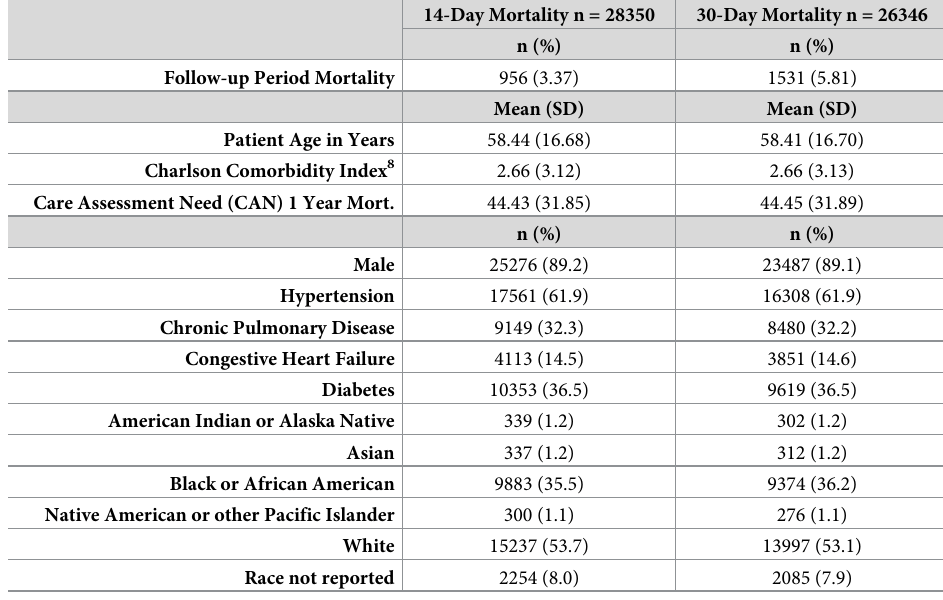
Table 1. Characteristics of the 14-day and the 30-day mortality assessment